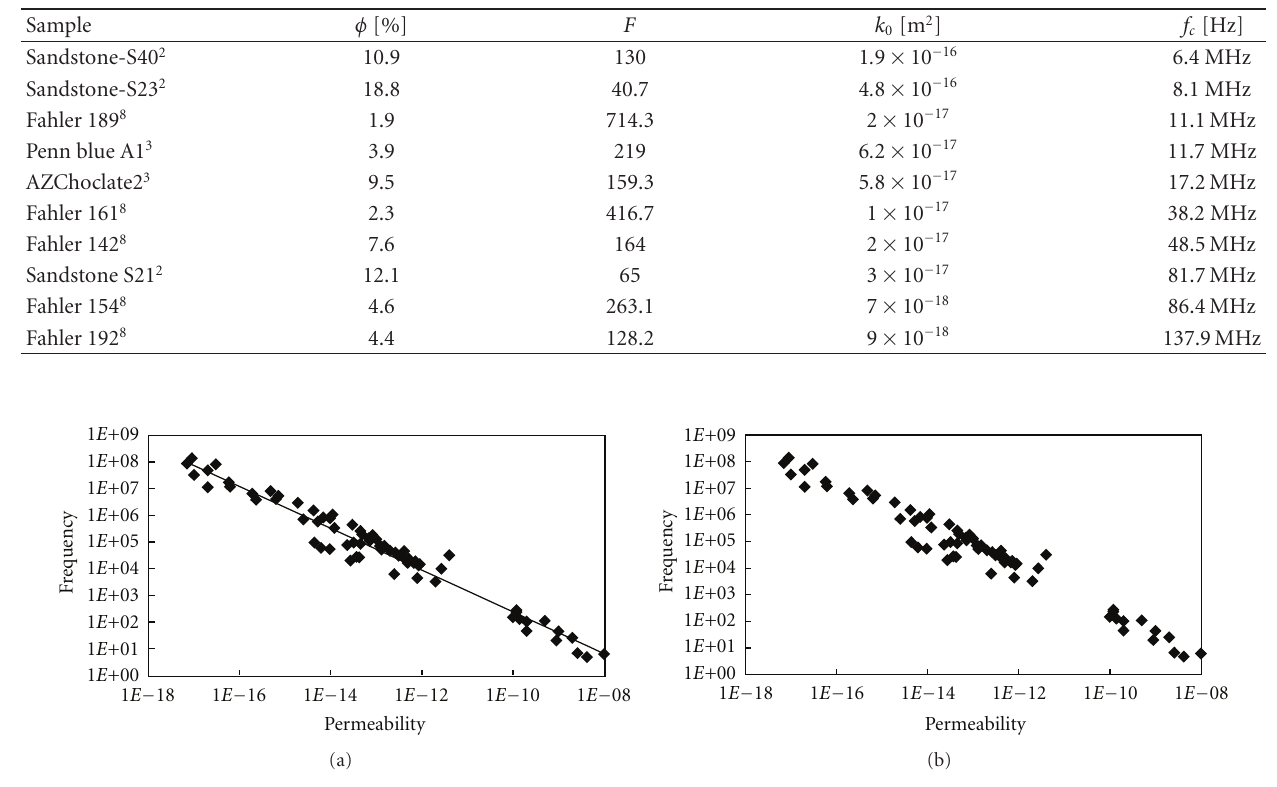
( f c ) = − 0 . 78log ( k ) − 5 . 5. The parameters of the 10 10